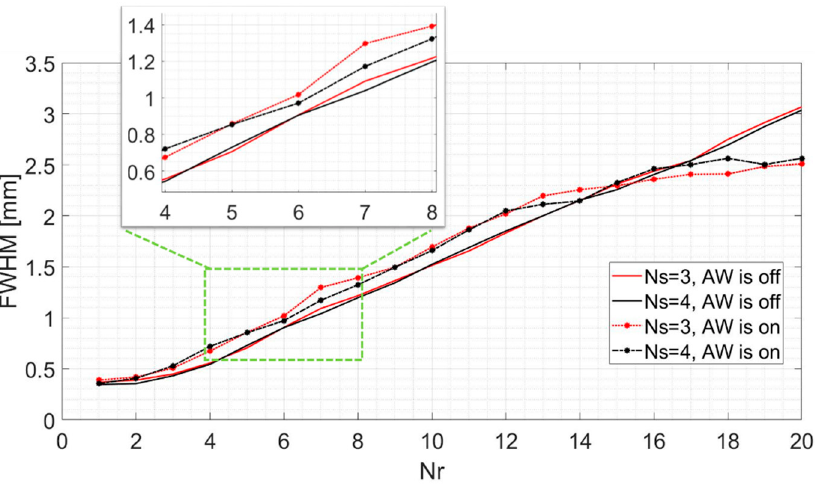
Figure 6. Full-width-half-maximum (FWHM) measurements for different Nr and Ns; a full-aperture transmission was used.